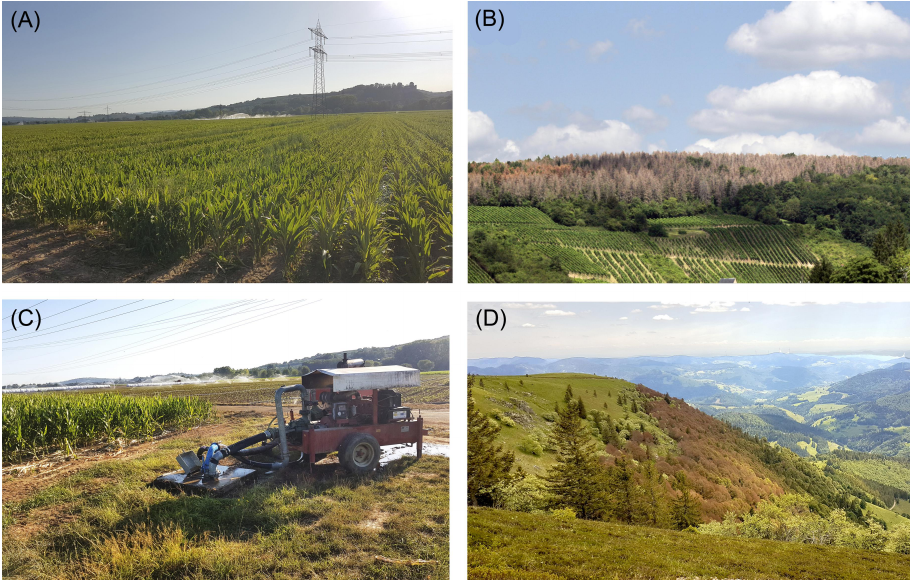
Figure 2. Extensive summer irrigation (31 July 2020) on maize in the Upper Rhine Area at noon during a sunny day ( A ) and low-altitude degradation of forest stands (spruce) in the western part of the Vosges Mountains at Contz-les-Bains (12 July 2020) ( B ). Intensive summer irrigation on maize and special crops (background) on 31 July 2020 (Tmax 38 °C) south-west of Freiburg (BaWue) ( C ) and frost damage in a beech forest stand at the Belchen (southern Black Forest) from 31 May 2020 ( D ). All images by the authors.